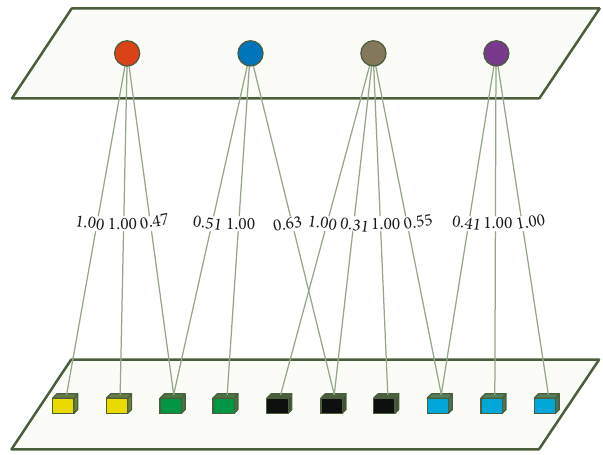
Figure 1: The example of bipartite